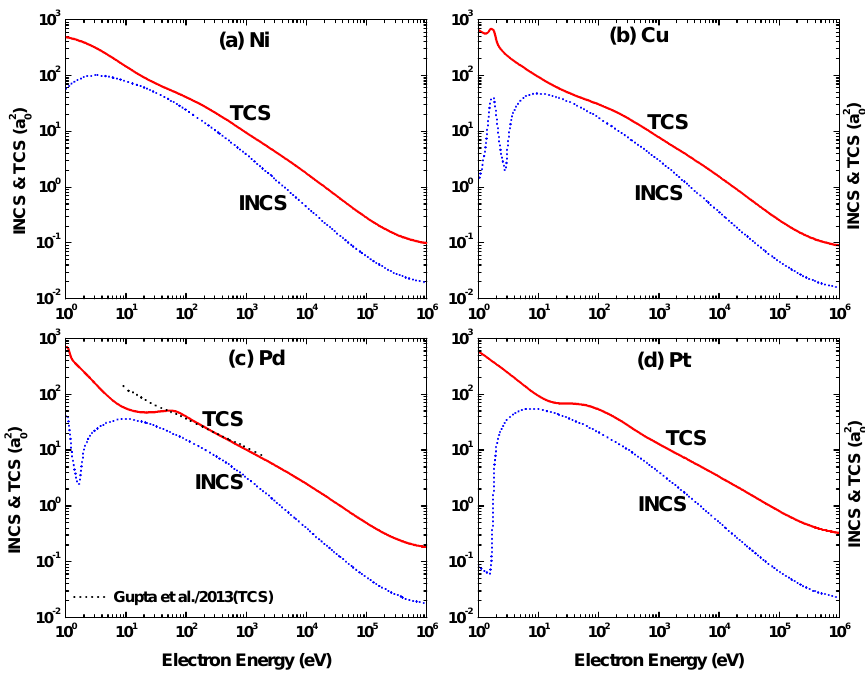
Figure 34. Energy dependence of the integrated inelastic cross-section (INCS) and total cross section (TCS) for electron impact scattering from ( a ) Ni 58 , ( b ) Cu 63 , ( c ) Pd 108 , and ( d ) Pt 196 . Theory: (—–) present OPM approach and ( · · · · · · ) Gupta et al.